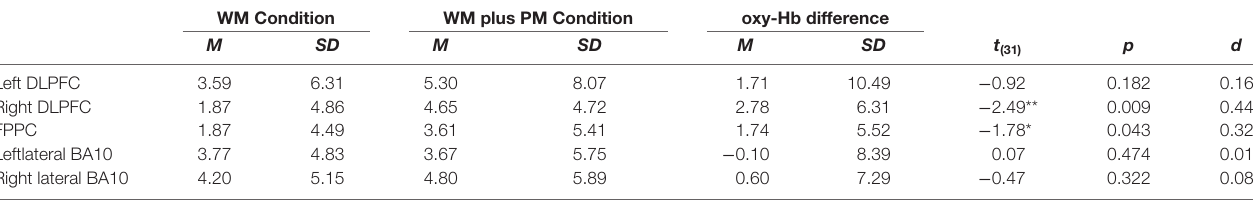
TABLE 3 | Descriptive statistics of oxy-Hb ( µ Mol × mm) in ROIs during WM condition and WM plus PM task ( N = 32).